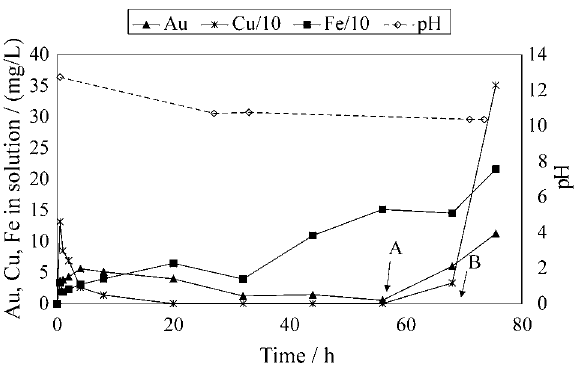
Figure 1. Product cyanidation using 0.5% NaCN solution; 1 kg of product, 1 L of solution, 50 g of lime; 0.17 and 4.32 g NaCN were added to the pulp at times A and B, respectively.